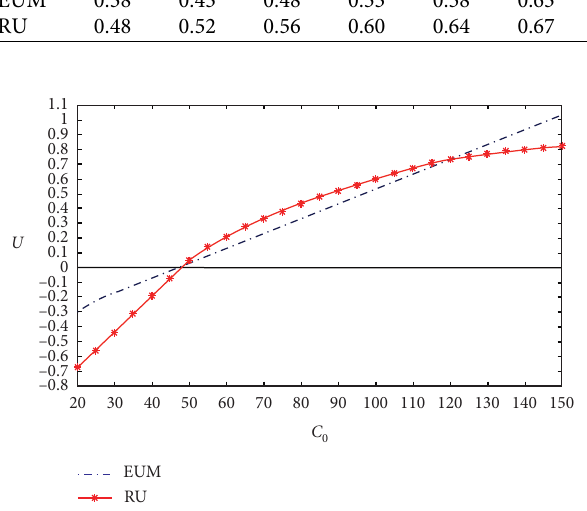
Figure 6: Comparison of RU and EUM ( T